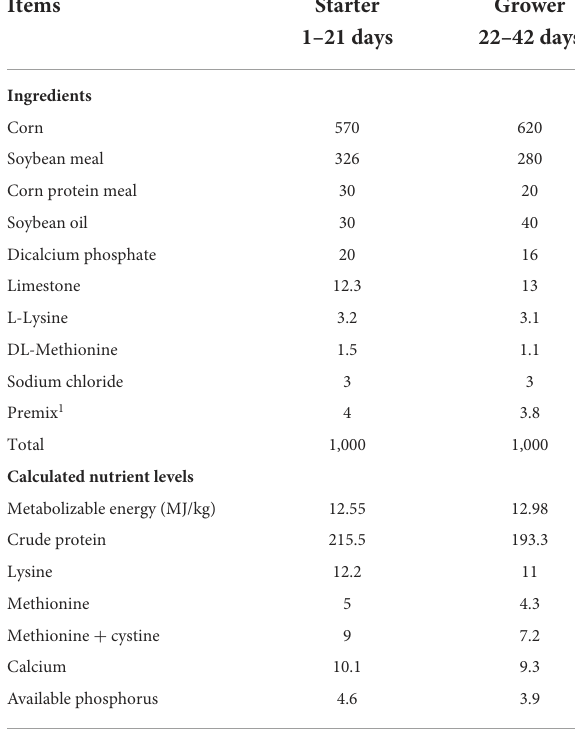
TABLE 1 Ingredient composition and calculated nutrition content of basal diet for Ross-308 broilers (g/kg, as-fed basis unless otherwise